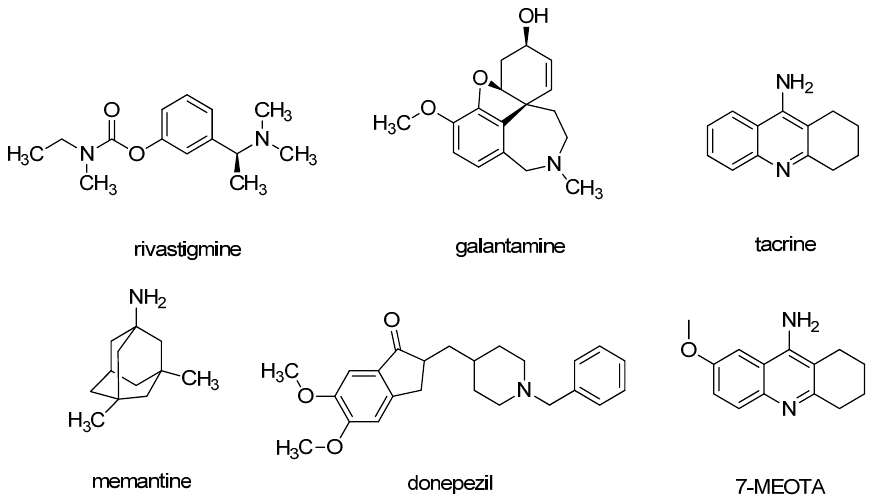
Figure 1. Chemical structures of AChEIs and NMDAR antagonist memantine for the AD treatment.